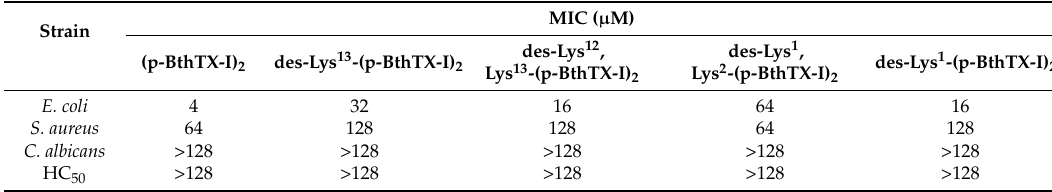
Table 3. Biological activities of the synthetic peptides (p-BthTX-I) 2 and des-Lys 12 /Lys 13 -(p-BthTX-I) 2 . Bacterial Table 2. Biological activities of the synthetic peptides.